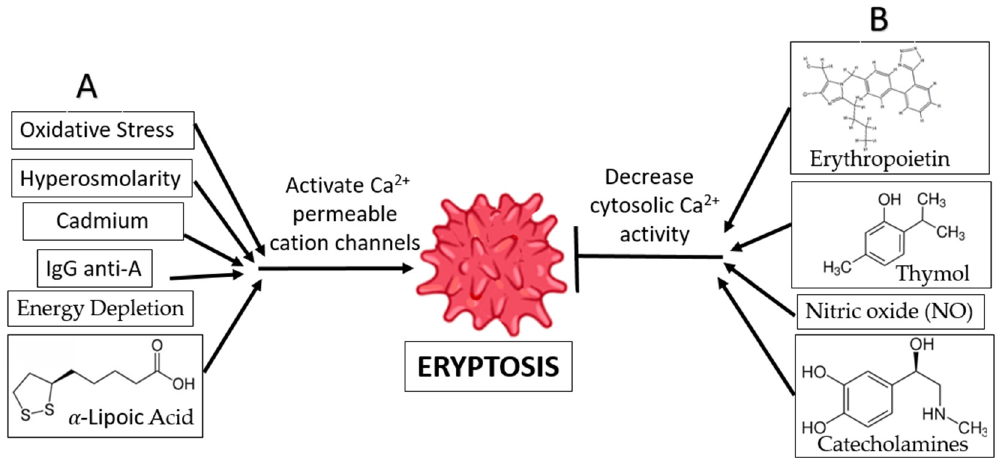
Figure 3. Modulation of Eryptosis. A : Adverse conditions, as well as some compounds, can trigger eryptosis by increasing intracellular Ca 2+ levels. B : Many compounds can prevent eryptosis by decreasing the cytosolic Ca 2+ activity.